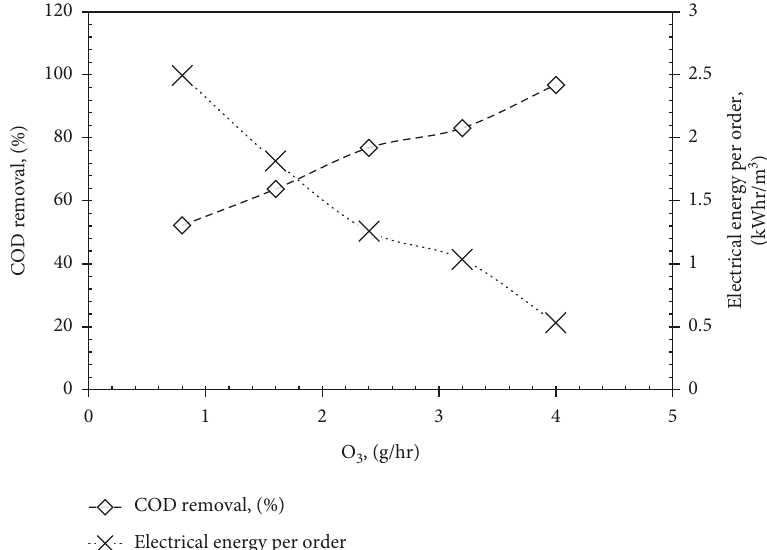
Figure 7: Effect of O 3 inlet concentration on % COD removal and EE/O in the O 3 /Fe COD–1600 mg/L; reaction time–4 h; O 3 flow rate–20LPM; H2O2–100mM; Fe 2+ –20mM; and